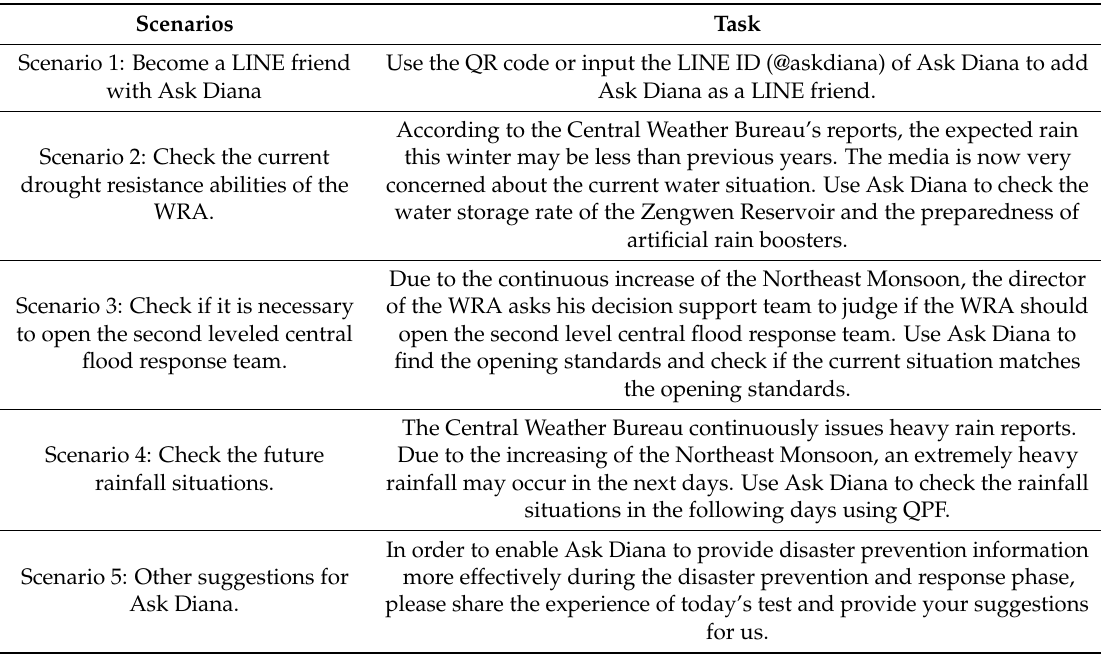
Table 3. Designed tasks for usability